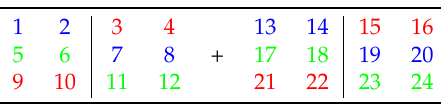
Table 5. Winding Distribution Table with t (cid:48) = 2 repetitions, for a winding with N = 24, p = 2 and m =